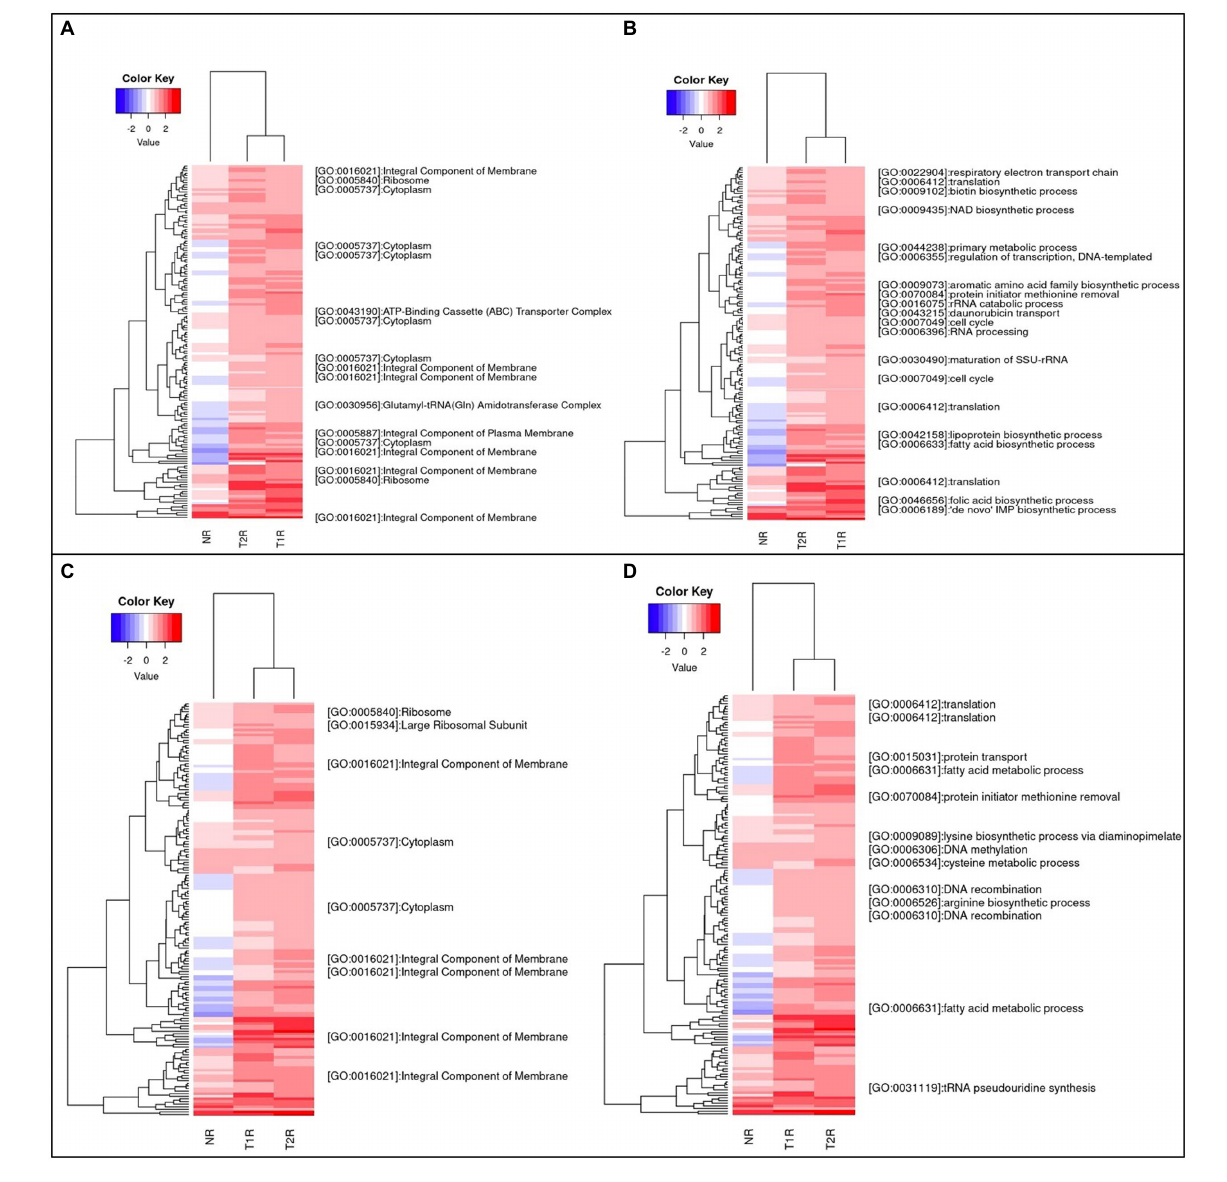
FIGURE 4 (A,B) represent heatmap of the genes that are upregulated in T1R in comparison to NR and (C,D) includes genes that are upregulated in T2R in comparison to NR. All the genes listed are significantly overexpressed ( p < 0.05) and the color key represents the Log2FC values for each gene ranging from − 2 to 2. The blank lines in GO terms are genes without GO annotations. In both the figures, we retained both T1R and T2R gene expressions to visualize expression changes across the sample